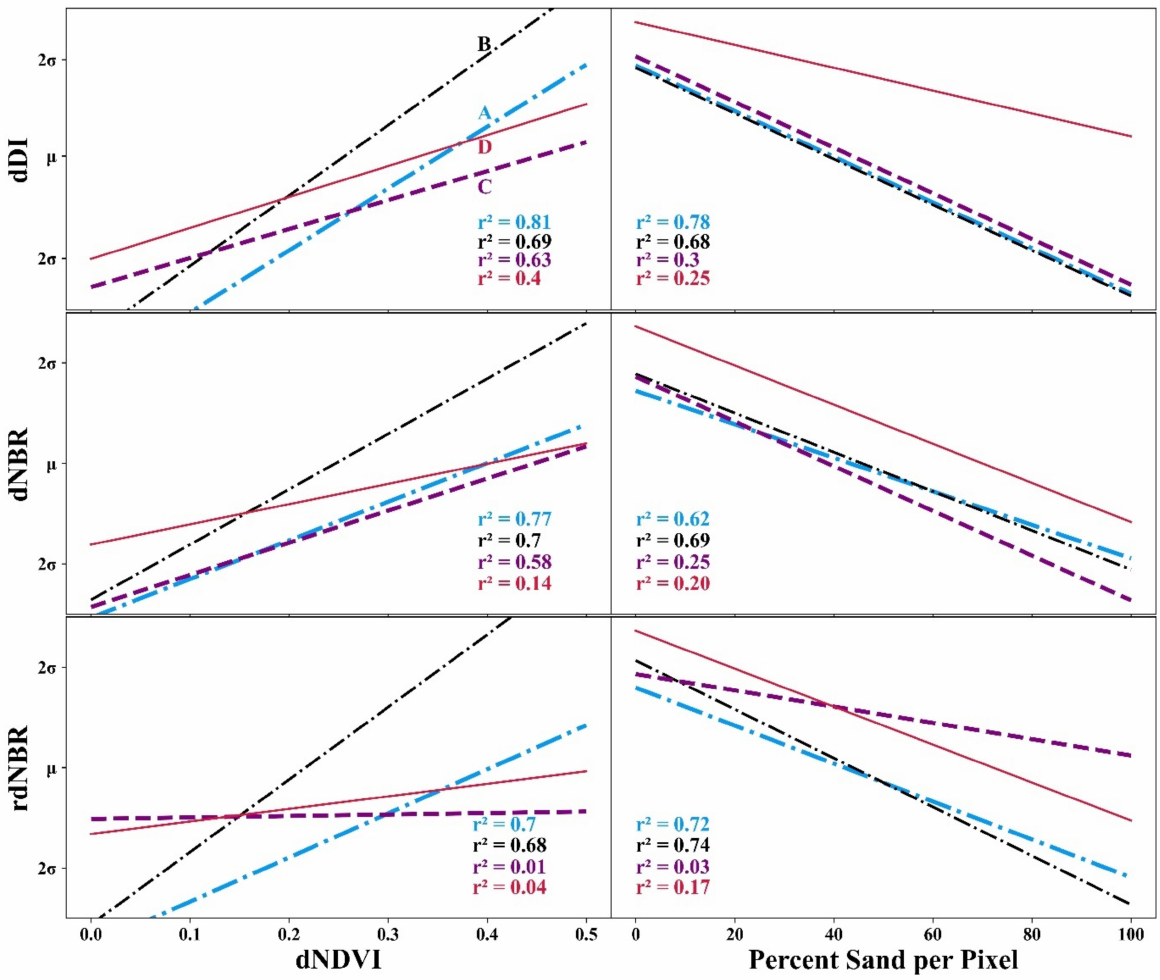
Figure 10. Trend lines and coefficient of determination (r 2 ) values showing the relationship between satellite-derived indices and aerial-derived fire severity from dNDVI (greenness and vegetation loss independent of exposed sand) and the total percentage per pixel of sand exposed pre-fire. Indices are compared at representative dune sites A–D with a direct comparison between S2 pixel locations and aggregated statistics (mean dNDVI and percentage of sand per